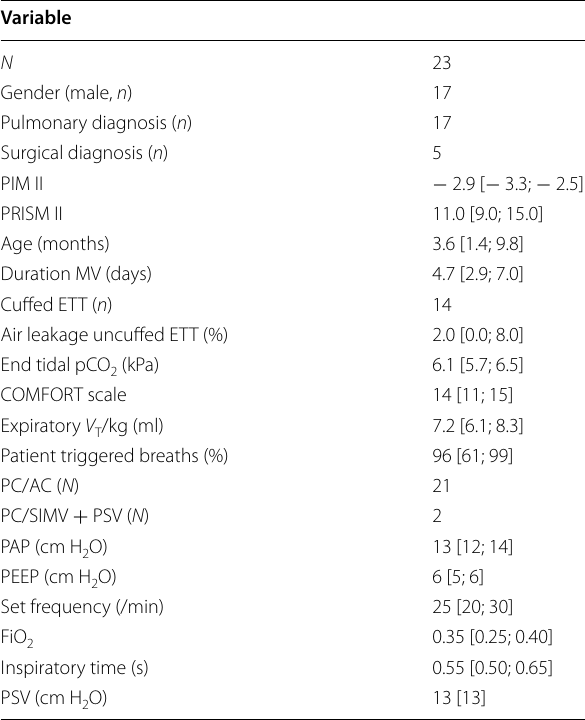
Table 1 Baseline demographics, mode of ventilation and ventilator settings